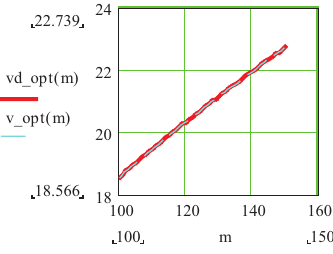
Figure 8. Practical coincidence of the extremals for the cases with taking into consideration the change of the aircraft speed and ignoring such